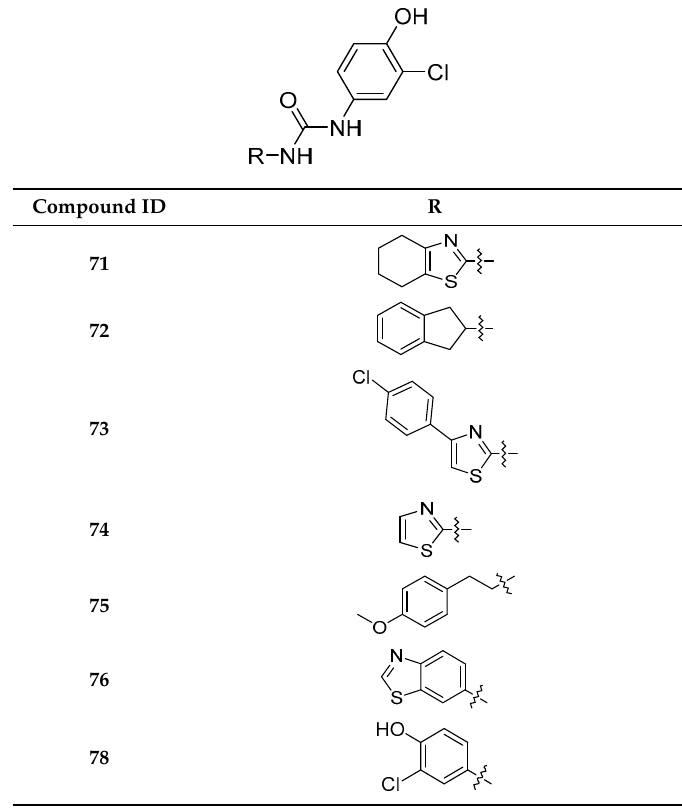
Table 4. Fourth series of prepared compounds ( 71 – 78 ).